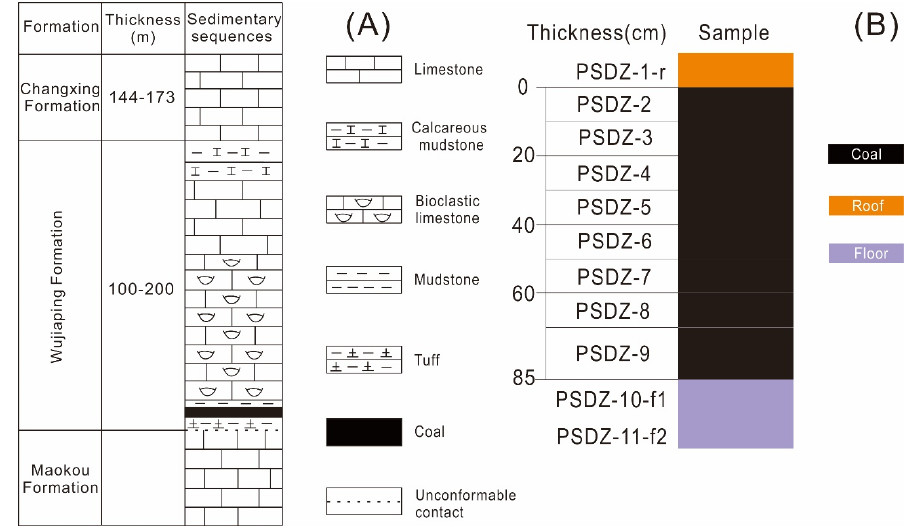
Figure 2. Sedimentary sequences ( A ), and sampling profile ( B ) in the Donggou coals.